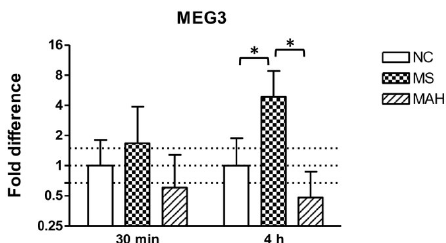
Figure 1. Maternally expressed 3 (MEG3) expression of THP-1-derived macrophages in response to Mycobacterium smegmatis (MS, dotted columns) or M. avium subsp. hominissuis (MAH, dashed columns) compared to the negative control (NC, white columns). Dotted lines indicate the fold differences to negative controls (0.67, 1, and 1.5). The area between the outer dotted lines indicates balanced expression between samples and controls. MEG3 is significantly upregulated by MS 4 h post infection (p.i.) compared to NC and MAH. Asterisks summarize p -values (unpaired t -test; * p < 0.05). Columns show means of three biological replicates ( n = 3) and bars show the standard deviation.